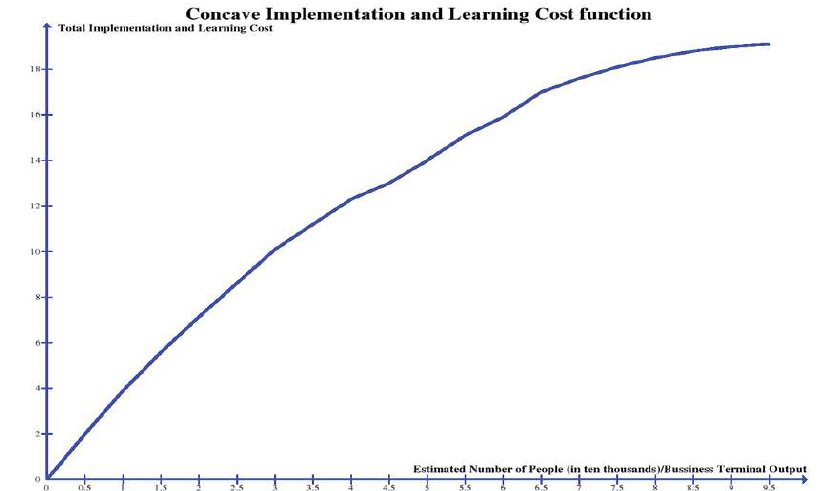
Fig. 1. A computer sketch derived from conceptual expectation of the total implementation and learning cost with respect to estimated number of business terminal output units